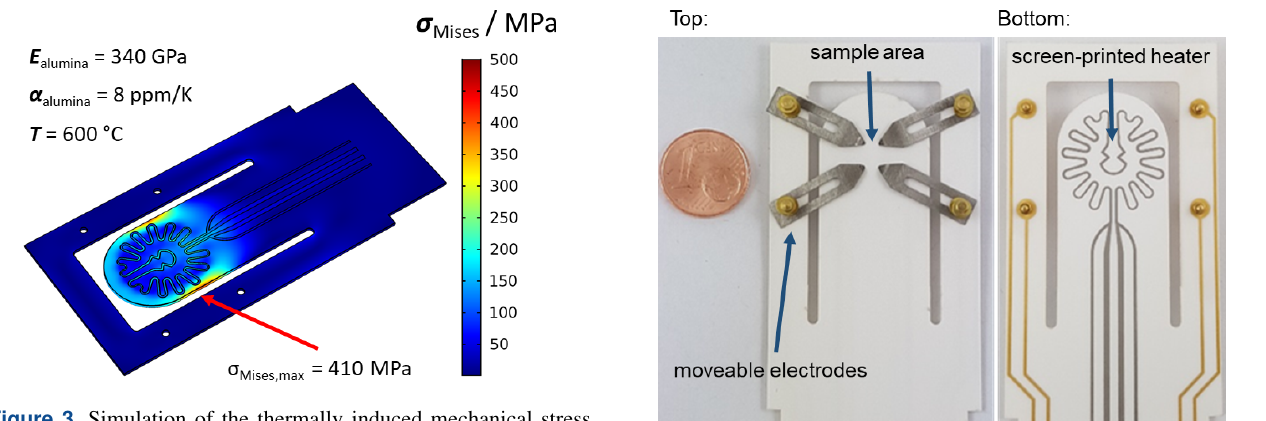
Figure 3. Simulation of the thermally induced mechanical stress within the sample holder at a temperature of 600 ◦ C.